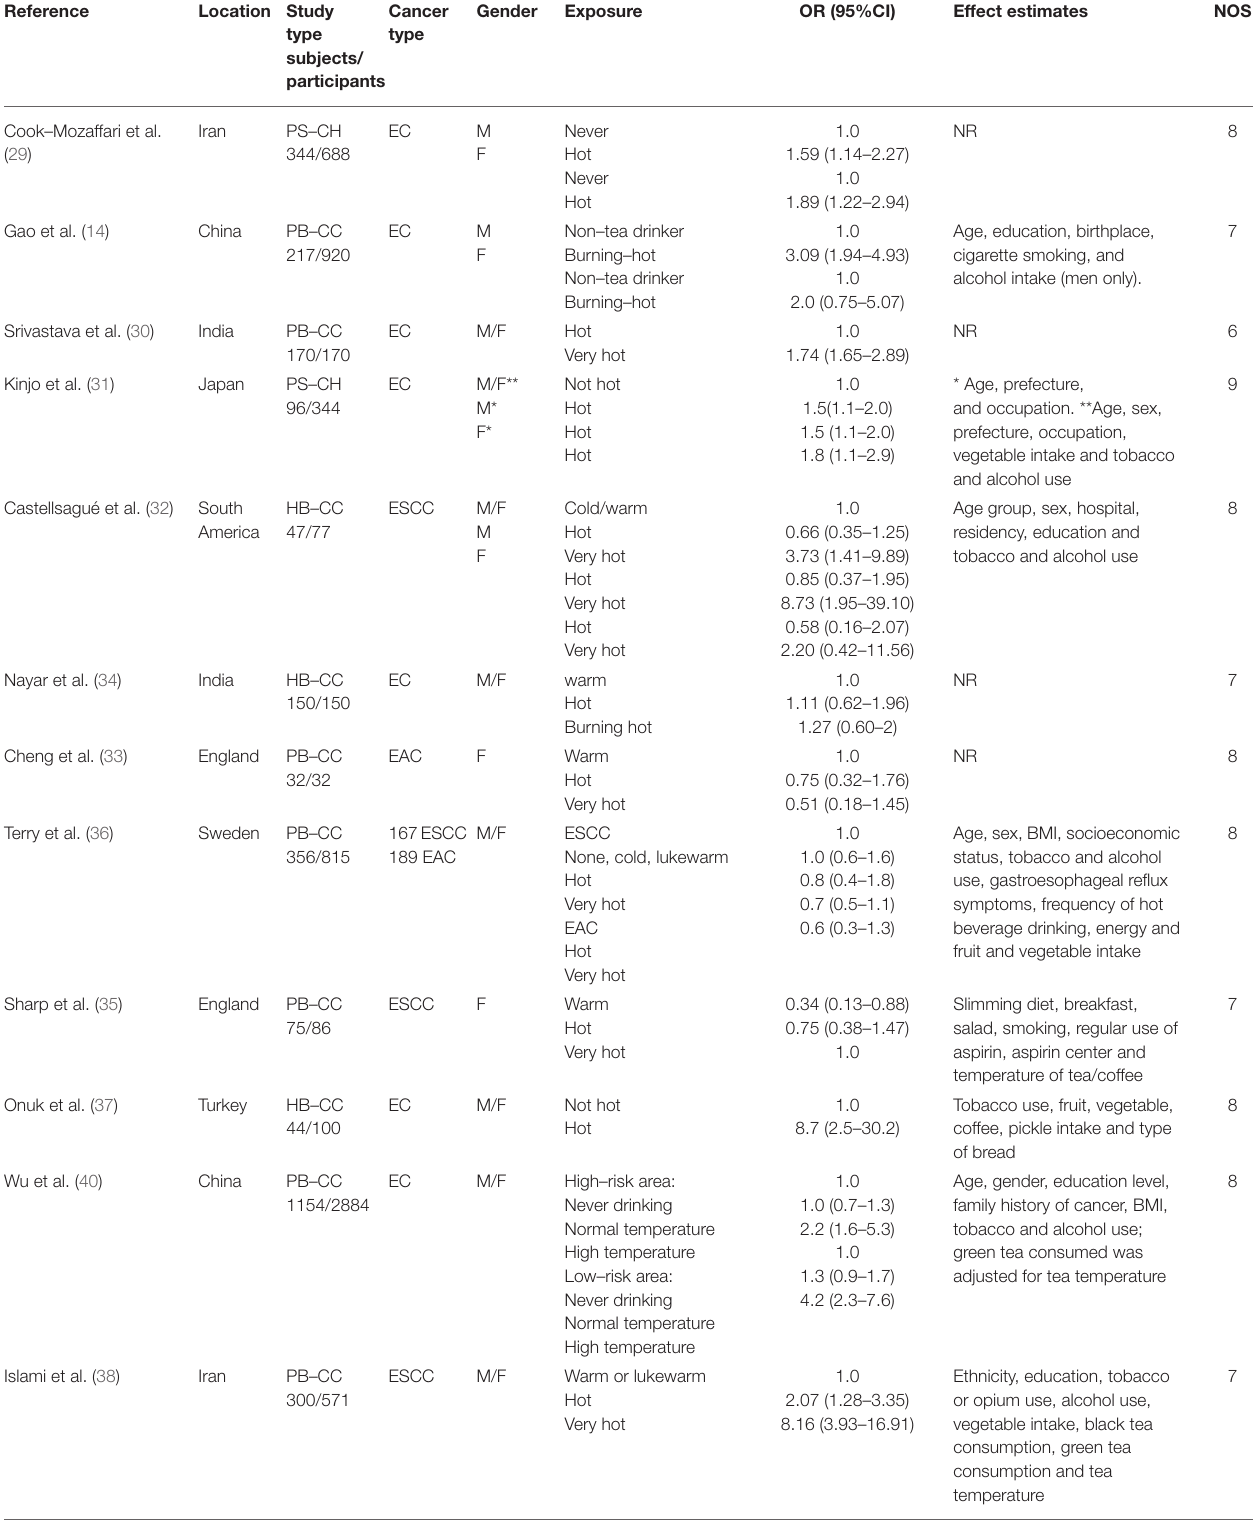
TABLE 1 | Characteristics of studies included in the